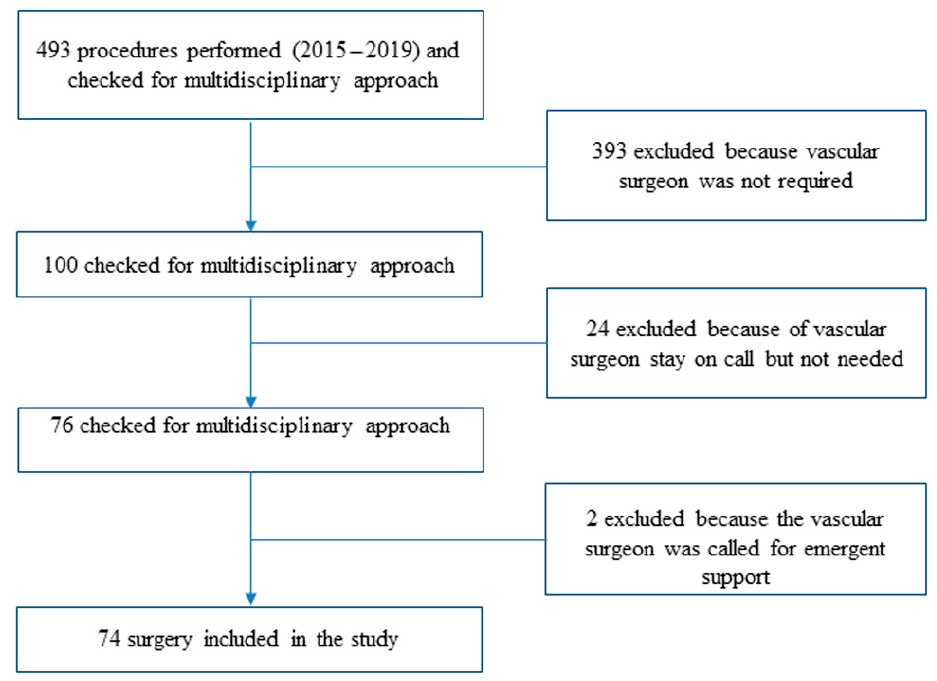
Figure 1. Patients’ cohort selection process.